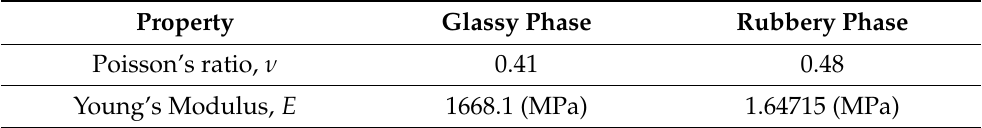
Figure 4. SMP viscoelastic properties and phase transition behaviour from the DMA test: ( a ) storage modulus; ( b ) phase lag, tan δ . The glass transition temperature, T g at 46.83 ◦ C, is the peak of the phase lag curve (shown by the red dashed line) for this particular specimen. Table 1. Average Young’s modulus and Poisson’s ratio of the 3D-printed